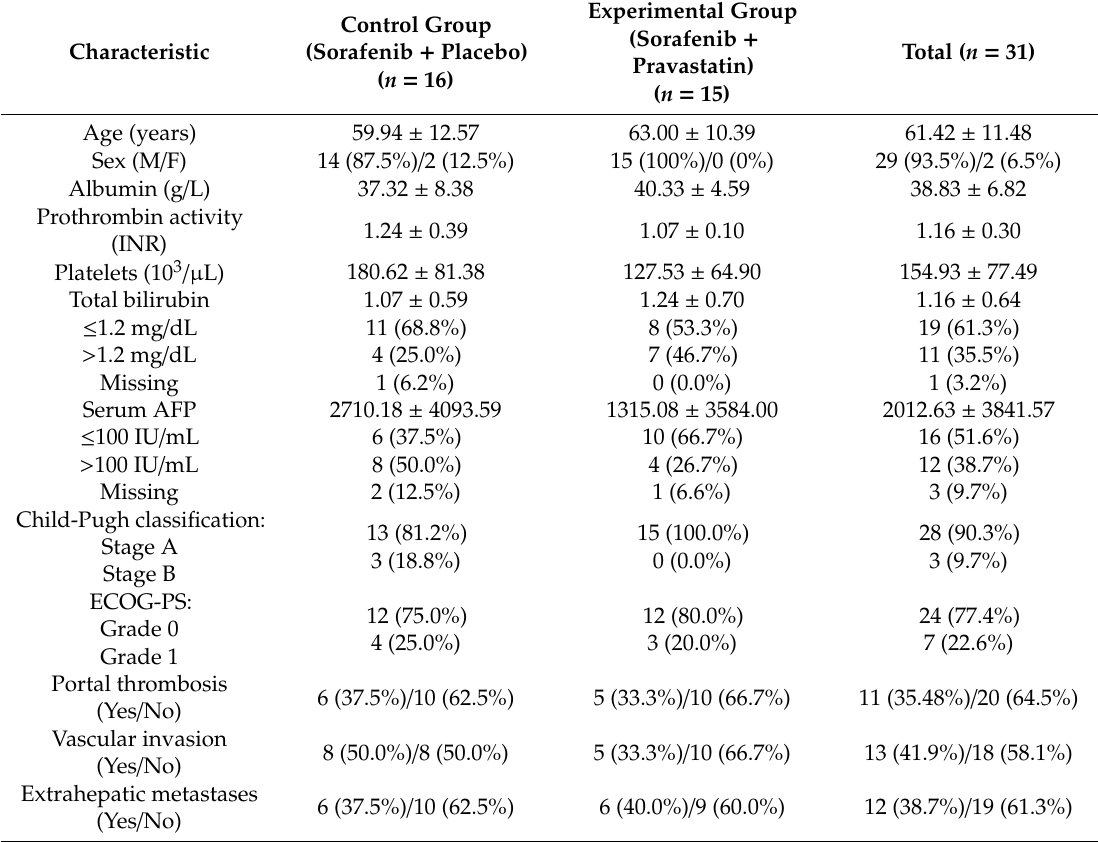
Table 1. Baseline characteristics of the study